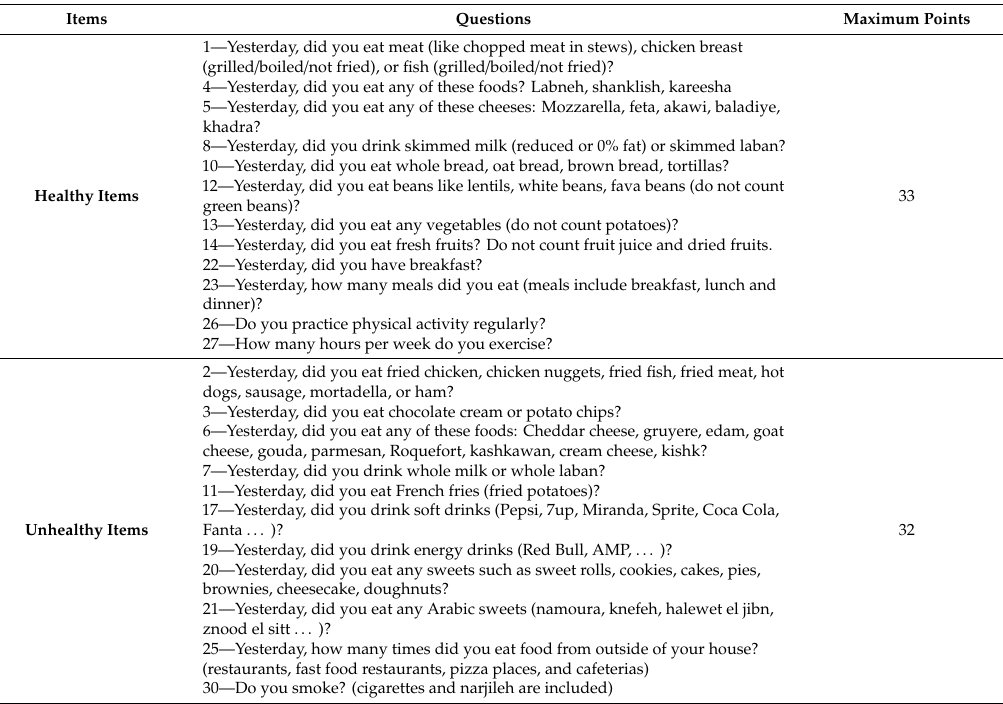
Table A4. Total adherence score components for the